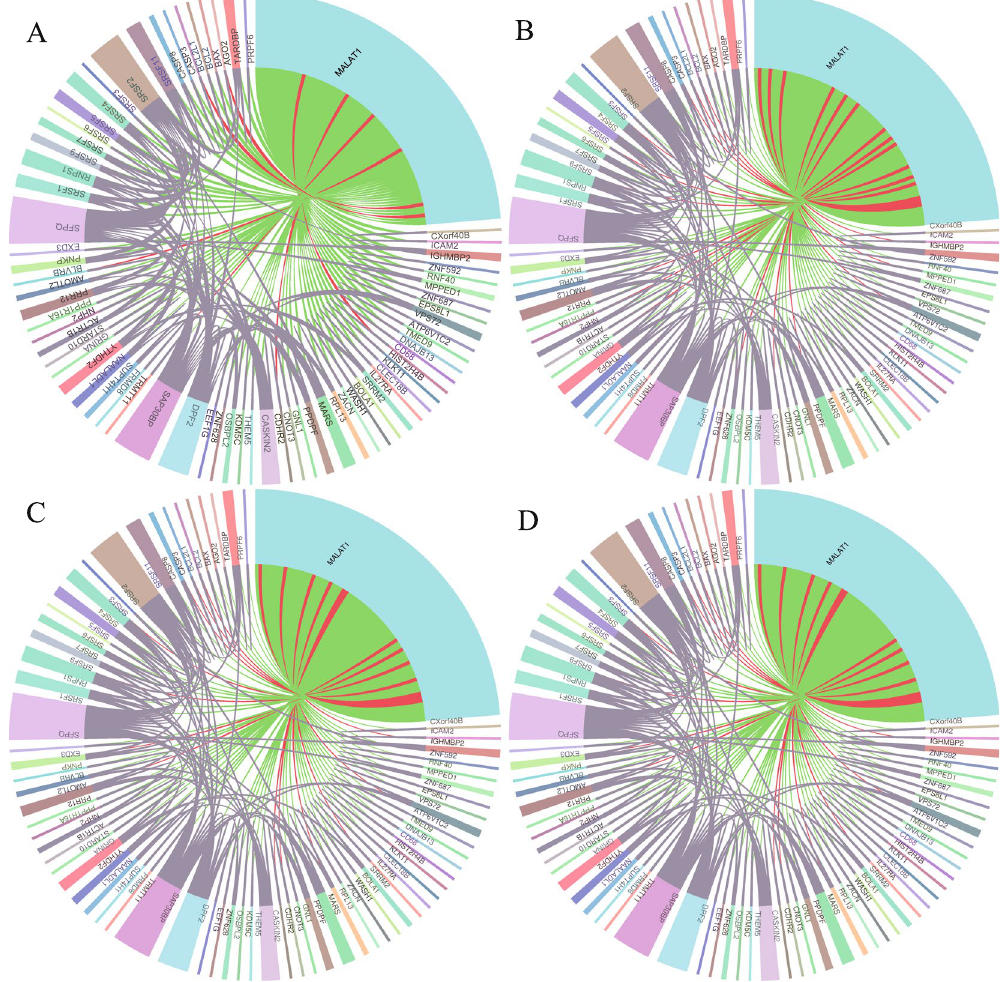
Figure 7. Case study of lncRNA MALAT1. The four chord graphs show the results of PLPIHS ( A ), PRINCE ( B ), RWR ( C ) and LPIHN ( D ) respectively. The biggest baby blue node represents lncRNA MALAT1 and the other nodes are related proteins, red lines denotes wrong prediction while green lines are correct prediction and the violet lines means the interactions between